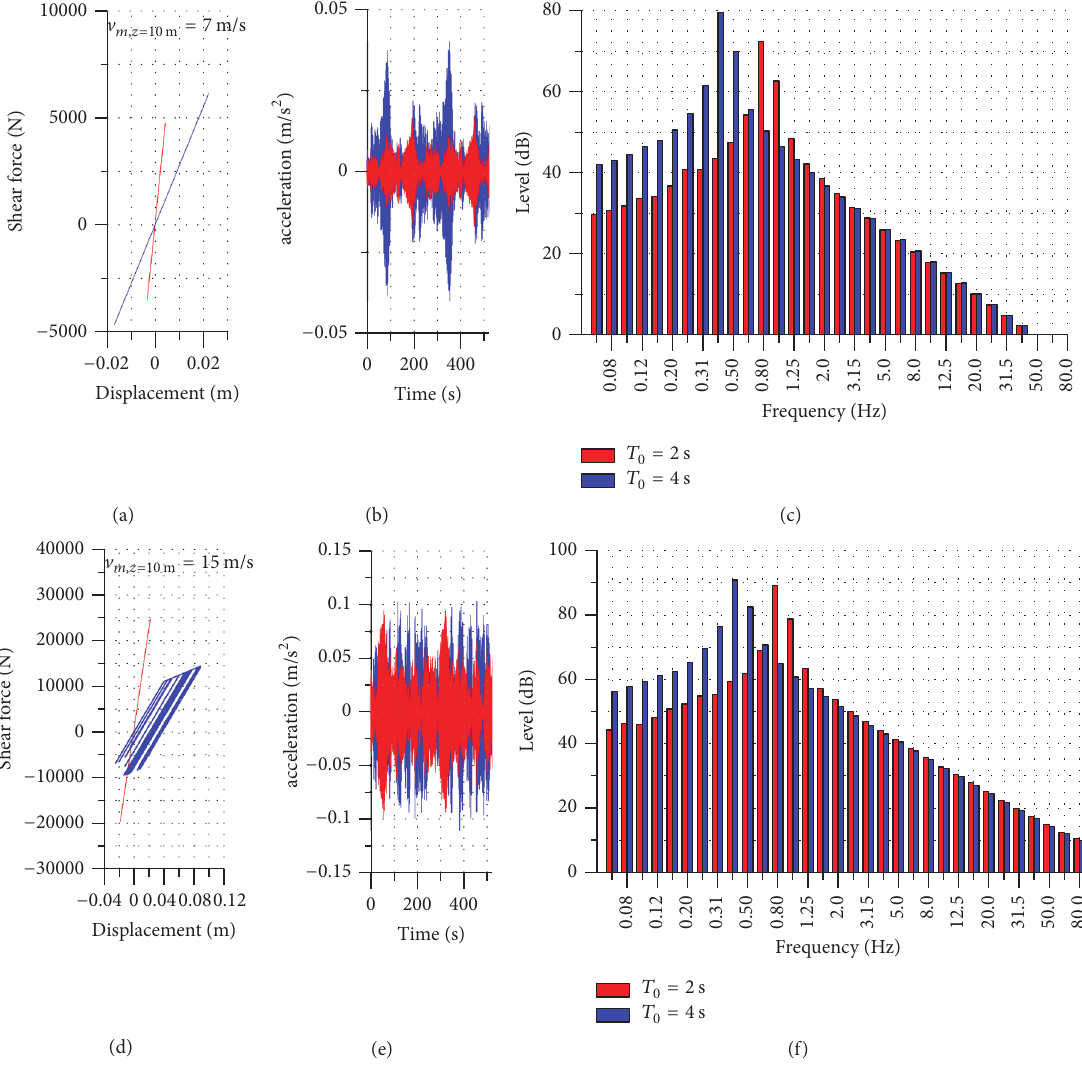
Figure 8: Example of nonlinear dynamic responses with values of the natural period of the equivalent linear system equal to 2 s and 4s: force- displacement curves (a, d), time histories of acceleration (b, e), and third-octave analysis levels (c, f) for a 10-minute mean wind velocity at 10m height equal to 7 m/s and 15m/s,